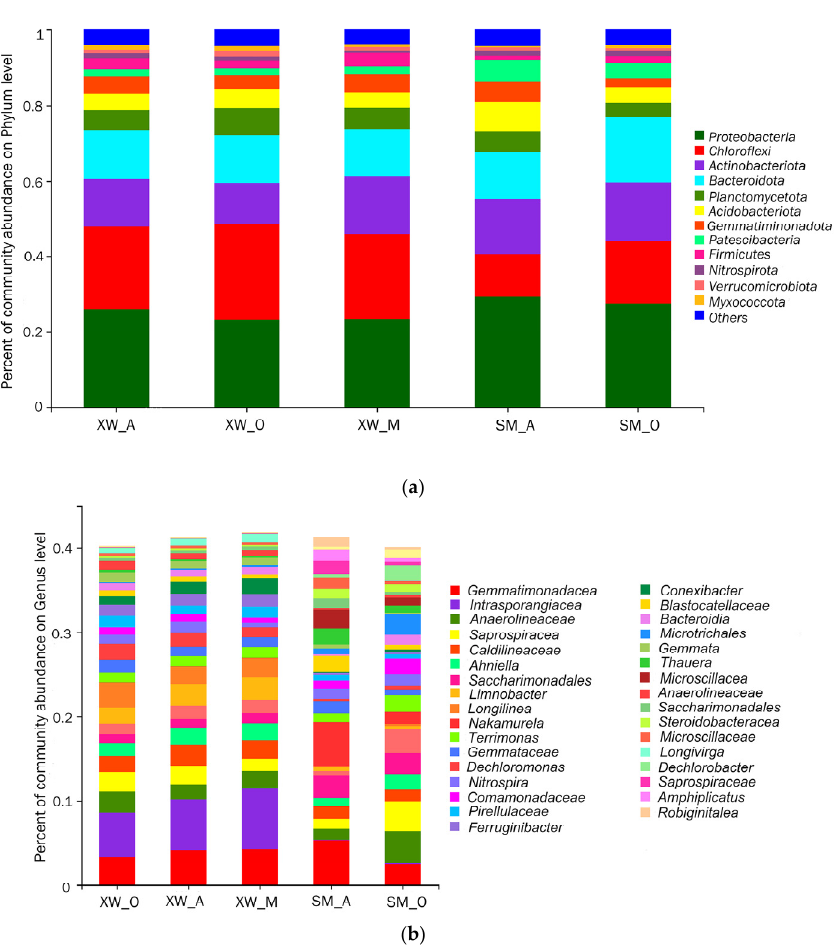
Figure 2. Microbial communities of the wastewater treatment plants: ( a ) phylum level; ( b ) genus